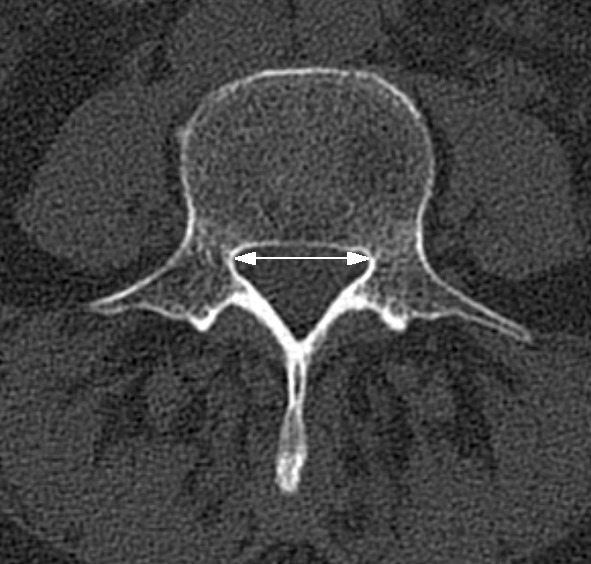
Transaxial computed tomography image of the lumbar spine at the level of L4. The white arrow indicates the transverse diameter of the osseous spinal canal.